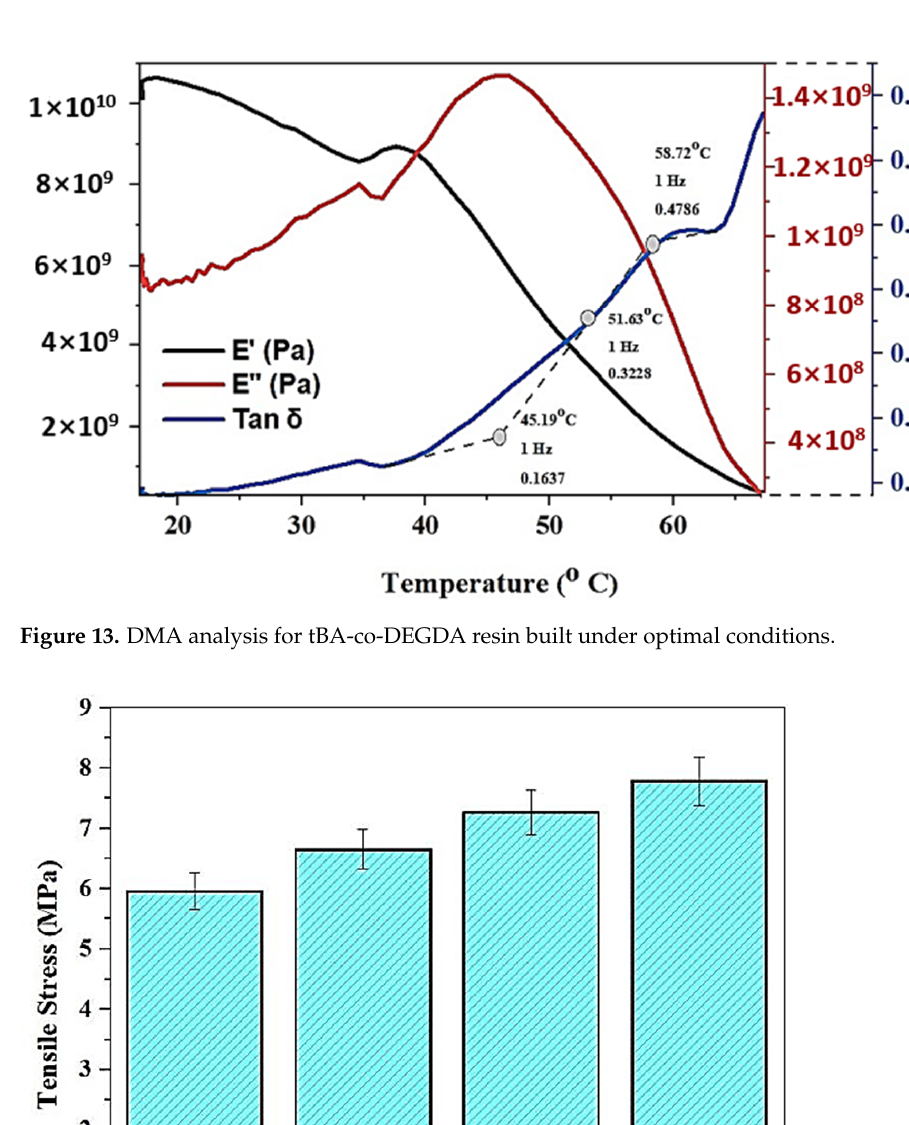
Graphene nanoparticles have a beneficial effect on the roughness values, and this, in turn, is used as a lubricant over the matrix for many resins. Graphene particles are nano-sized, and the addition of these particles removes the surface undulations, and the improvement of surface finish is increased with a higher percentage addition of graphene. The maximum R a value is 0.6461 µ m at 0 wt.% of graphene. The rate at which the surface improves is low for 0.3%, with only a marginal difference in values between 0.5325 µ m and 0.4912 µ m. A further increase to 0.5 wt.% resulted in the graphene particles forming weak adhesion and pulling out through the process of layer separation. In Figure 15 below, the graphical representation of the average surface roughness for various graphene compositions printed with a speed of about 90 mm/s and 110 pulses/s has been